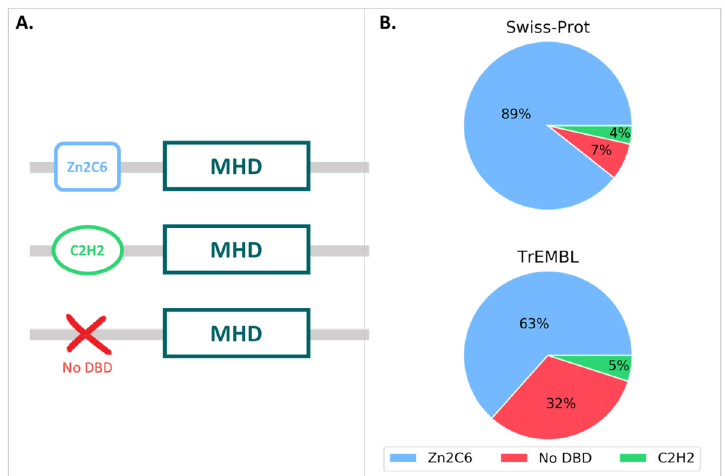
Figure 3. ( A ) MHD domain pairs found in the UniProtKB. ( B ) Proportion of each domain pair found in the Swiss-Prot and TrEMBL sections, with respect to the total number of MHD-containing se- quences.